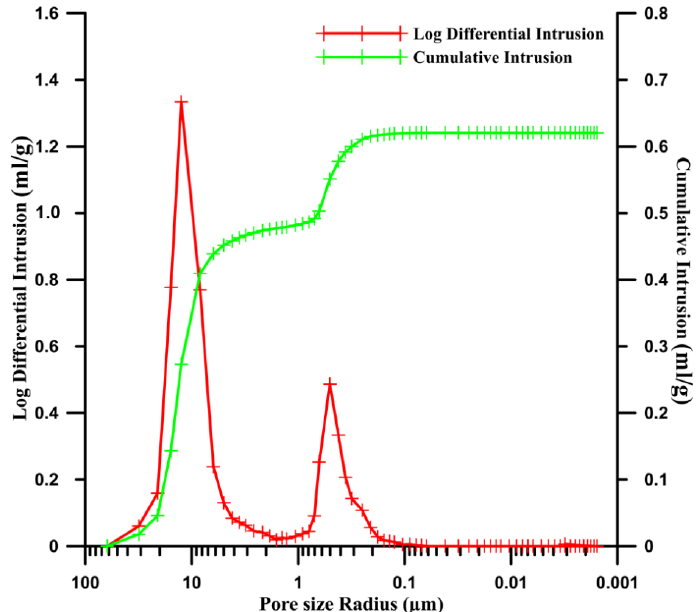
Figure 3. Measurement of the porosity of the hydroxyapatite particles with two distinguished peaks representing the interparticle space (first peak) and particle porosity (second peak).